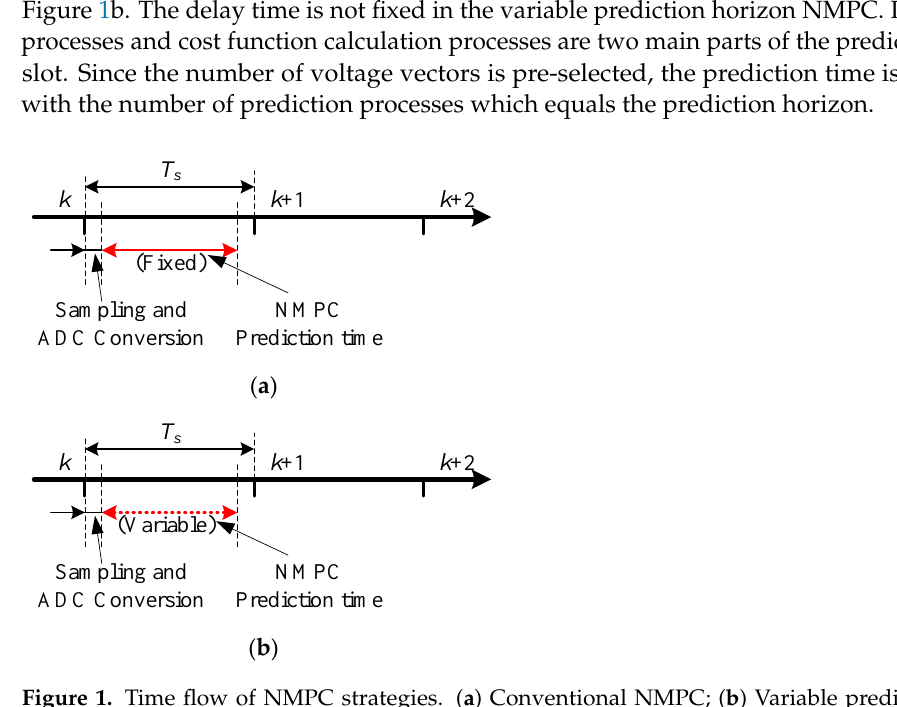
Figure 1. Time flow of NMPC strategies. ( a ) Conventional NMPC; ( b ) Variable prediction horizon NMPC.